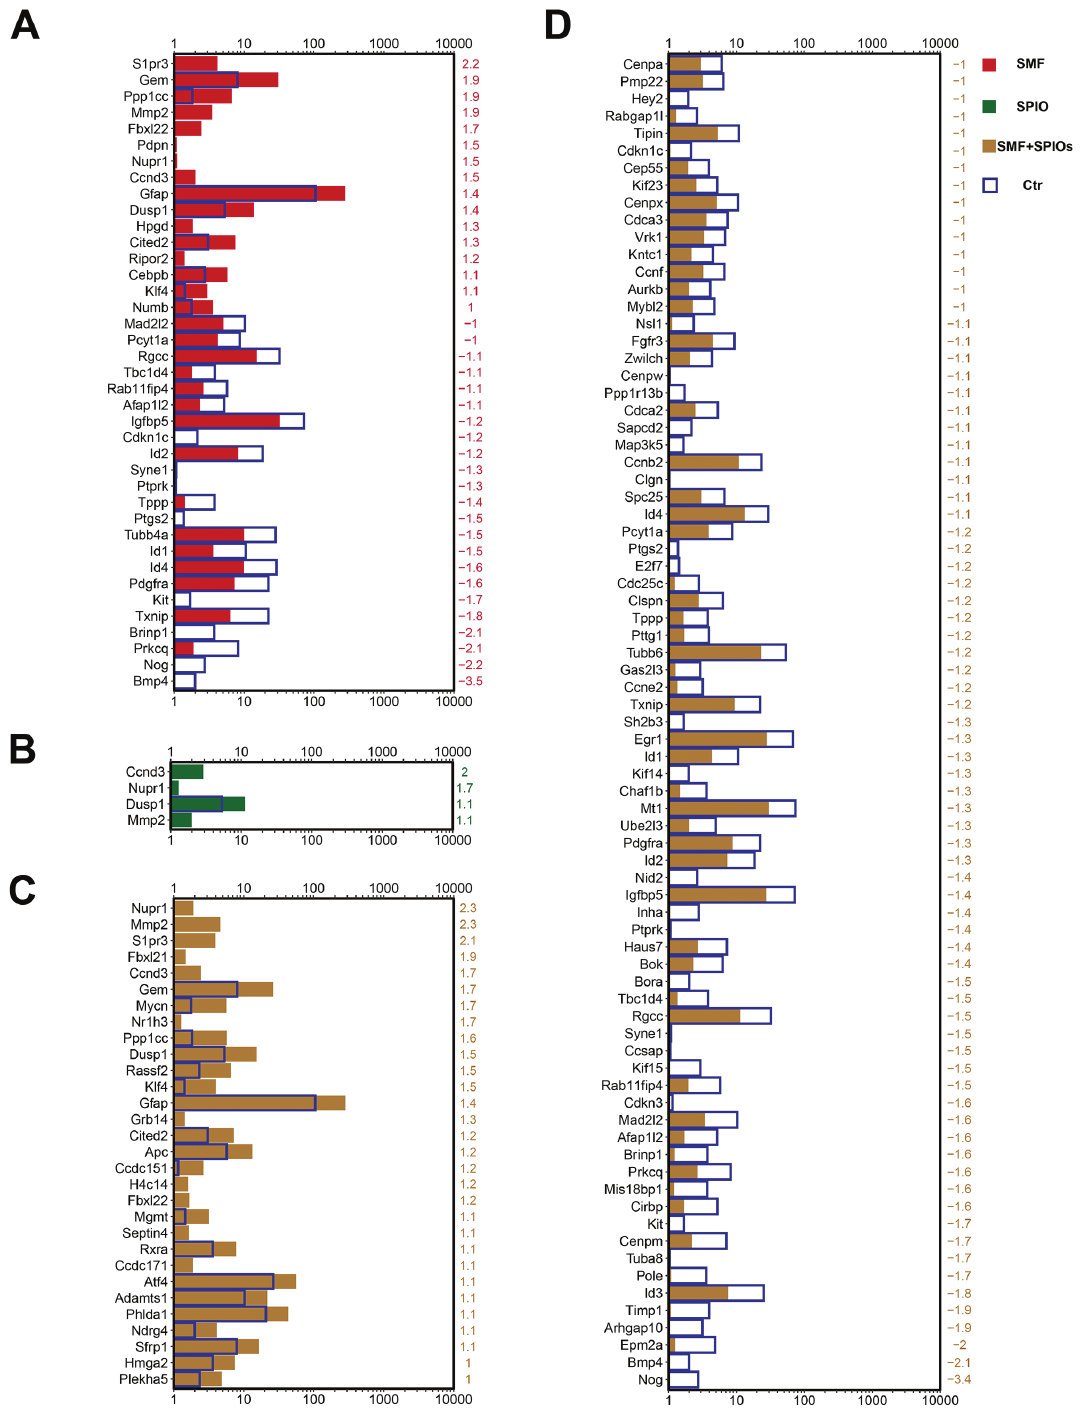
Fig. 4. Cell cycle-related differentially expressed genes of NSCs in the SMF group (A), SPIOs group (B), the SMF + SPIOs group (C), and control group for normal neurogenesis and regulate the proliferation and differentiation of NPCs (21). Atf4 gene encoded tran- scription factor ATF4, which connected with endoplas- mic reticulum (ER)-stress. ER stress can be caused by the